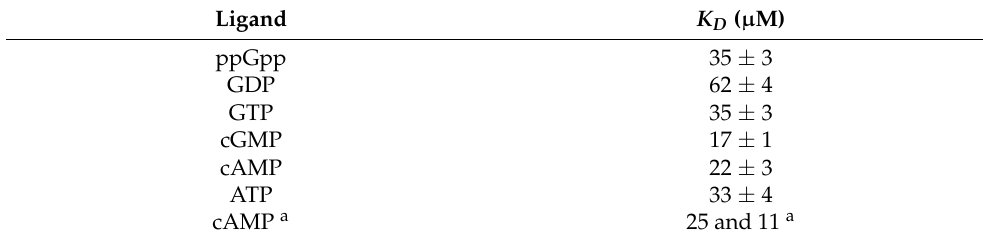
Figure 1. Binding of ppGpp to CRP determined by fluorescence spectroscopy. ( a ) The fluorescence Spectra of CRP in the presence of ppGpp. Following excitation at 280 nm, the emission spectra of CRP (2 µM) were recorded at 25 °C. ( b ) The fluorescence change (ΔF(area)) against ppGpp concentrations. Instead of using the fluorescence change at a fixed wavelength, the area below the spectra between 334 and 348 nm was used, and the area decrease (ΔF(area)) upon addition of ppGpp was utilized to calculate the extent of fluorescence quenching. The K D value for ppGpp-binding to CRP was calculated as 35 ± 3 µM. Table 1. The K D ’s for nucleotide ligands on CRP.